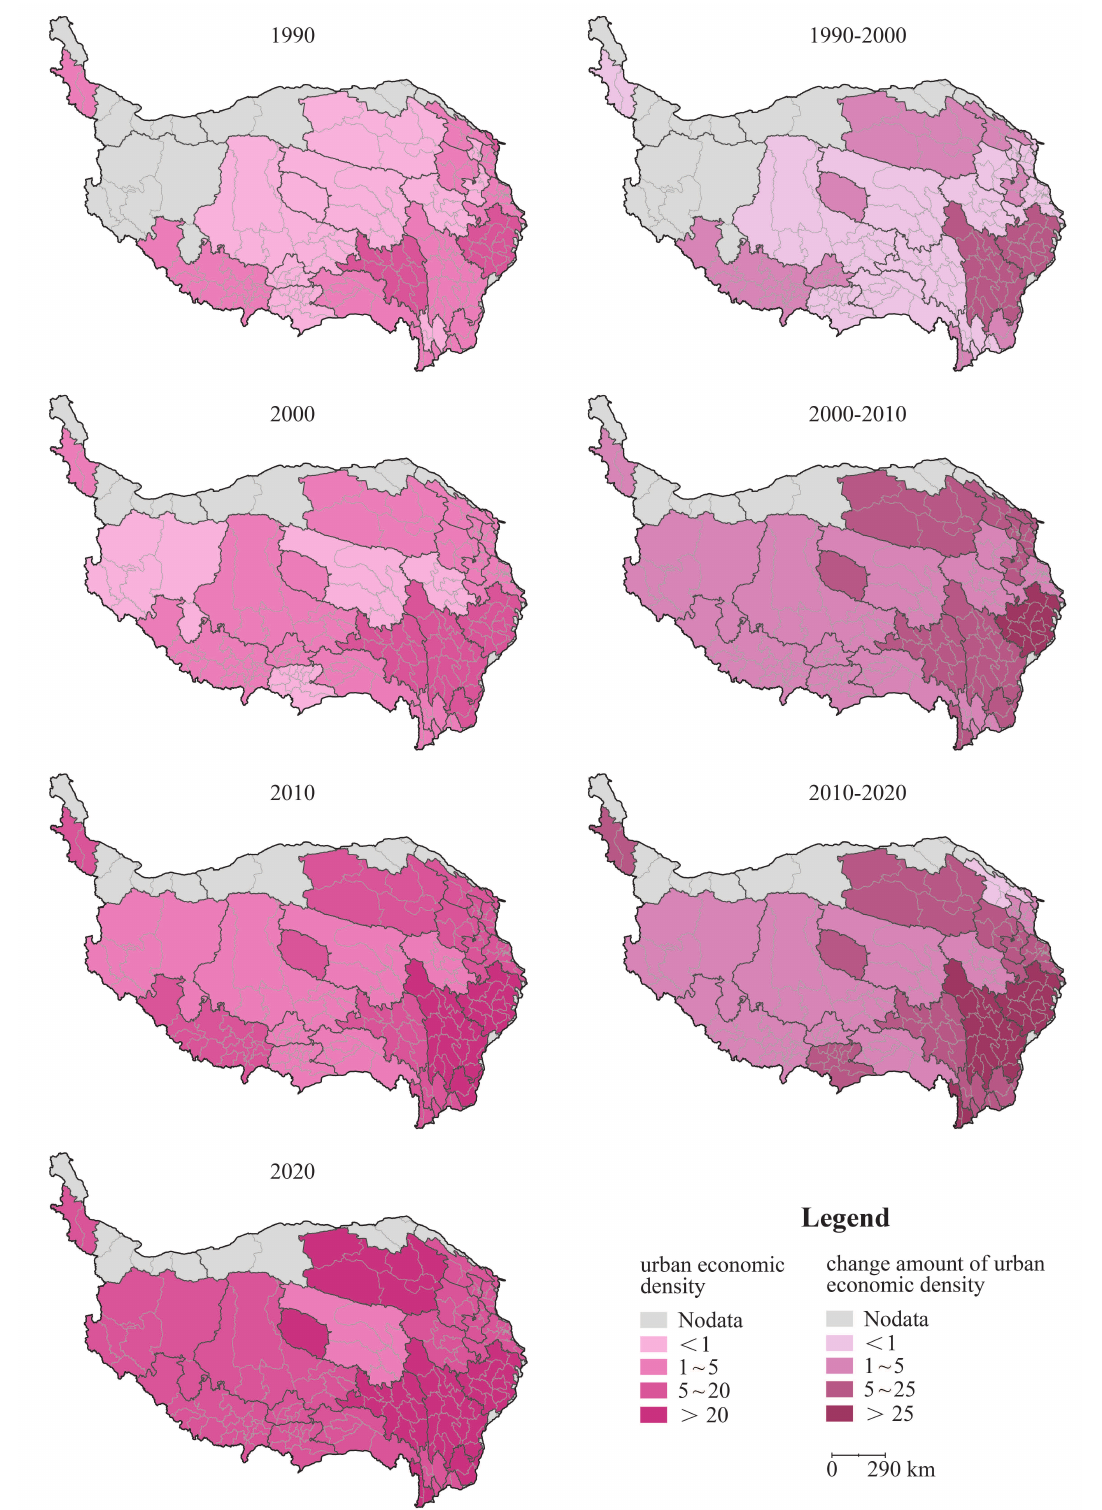
Figure 7. UED in the Qinghai–Tibet